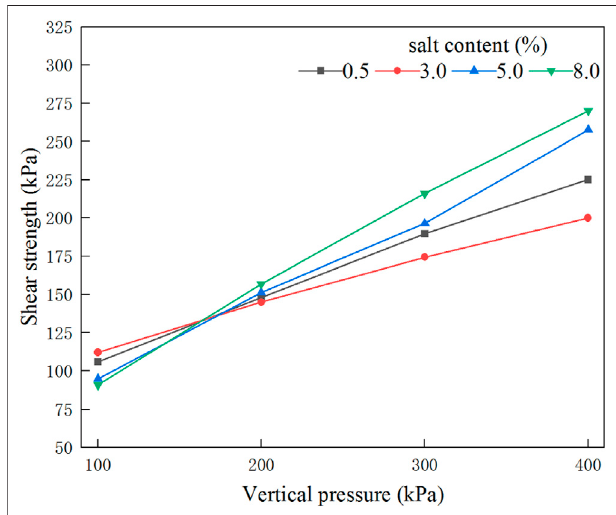
FIGURE 5 | Compression strength of sulfate soil with different sulfate content.